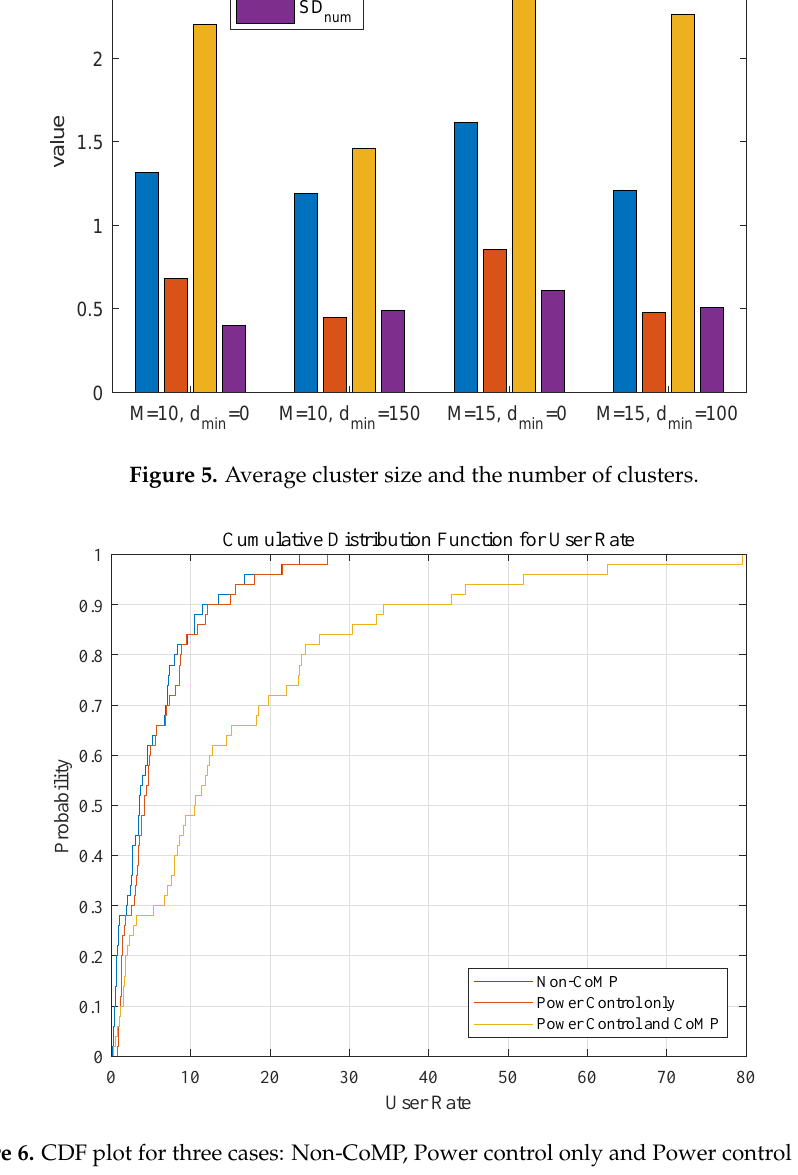
Figure 6. CDF plot for three cases: Non-CoMP, Power control only and Power control +